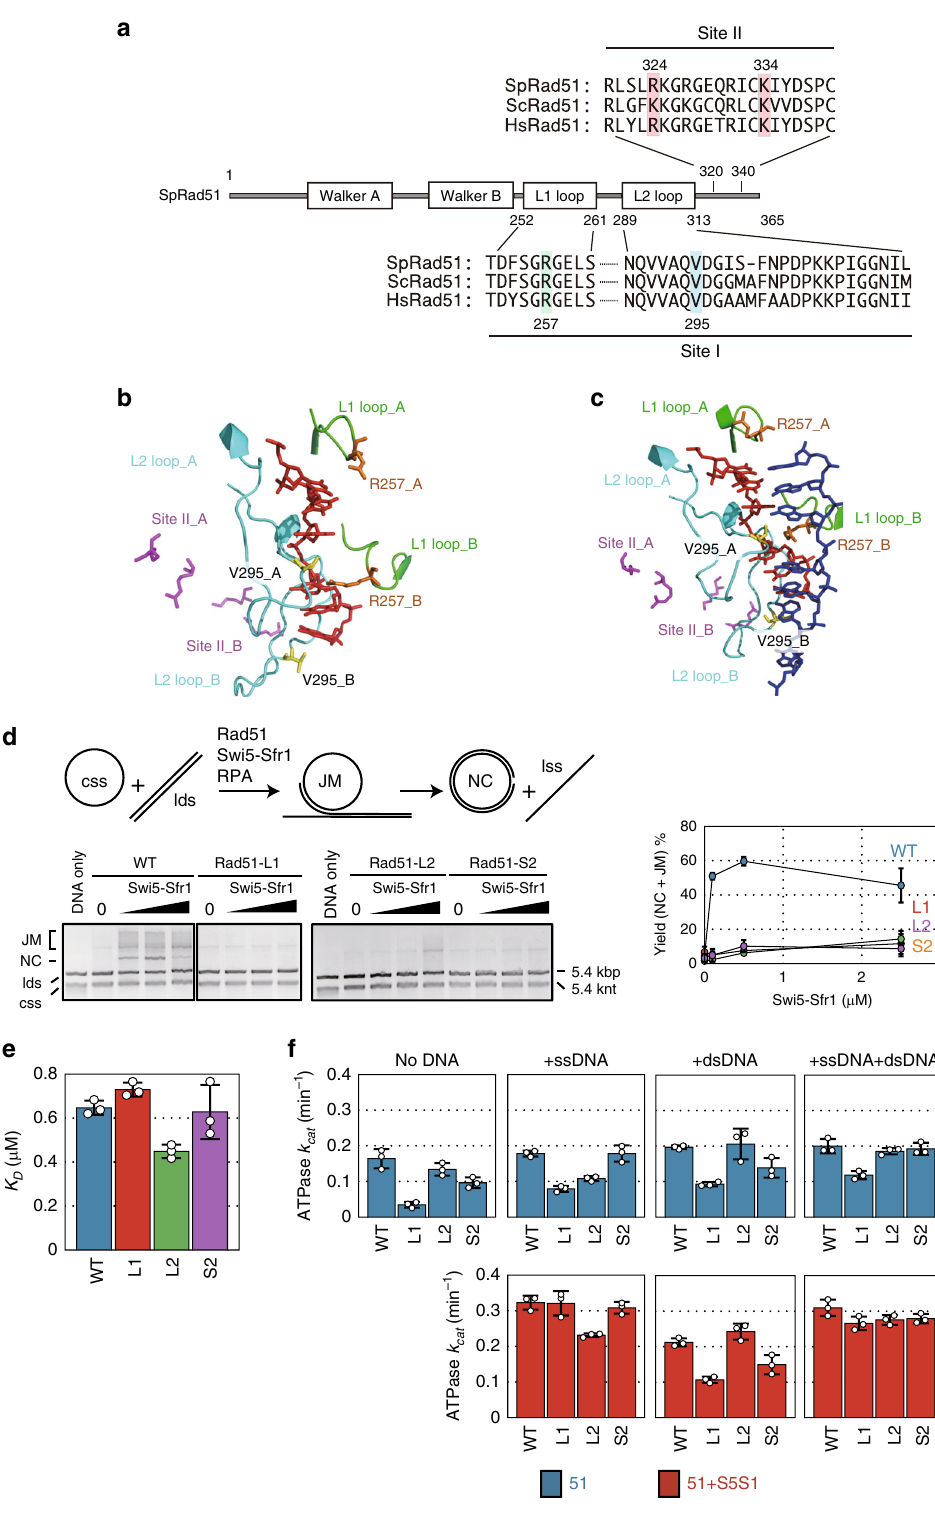
triplet gap of ssDNA and dsDNA to stabilize the invading strand and the heteroduplex DNA product, respectively 15,26 . Finally, Rad51-S2, a site II mutant, contains two mutations, Arg-324 to Ala and Lys-334 to Ala (R324A and K334A); these residues correspond to Arg-243 and Lys-245, respectively, in site II of RecA 15,25 . Since these two basic amino acid residues have been proposed to play an equally important role in DNA binding,